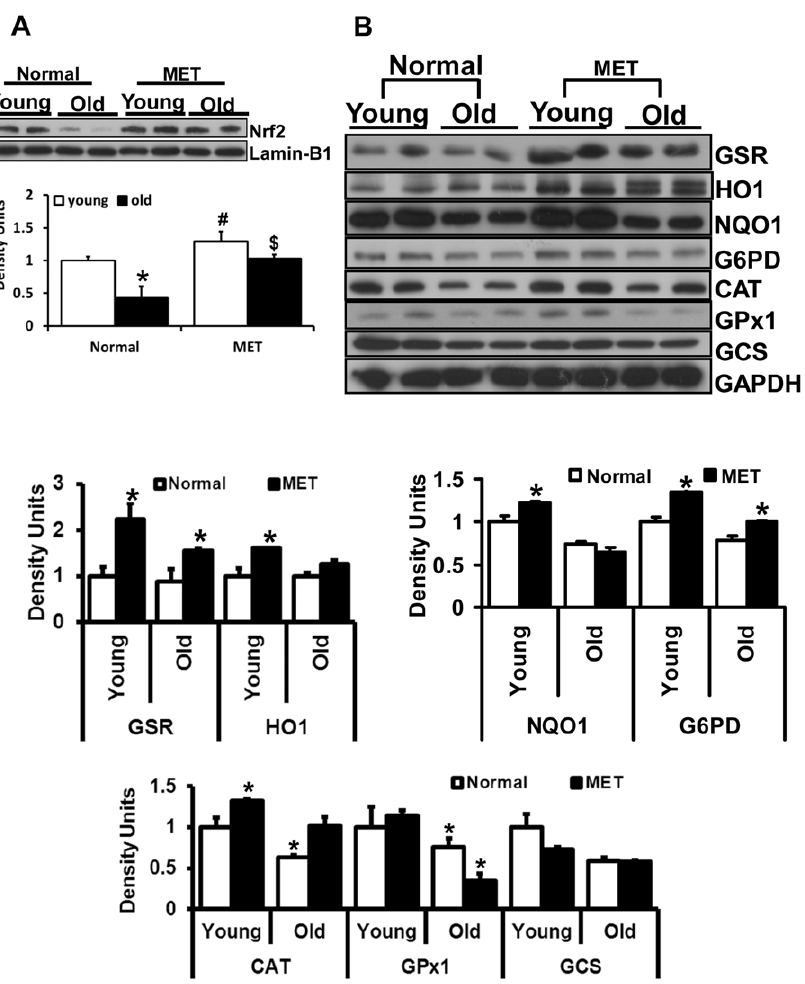
Figure 6. Effect of prolonged moderate exercise on Nrf2/ARE-Antioxidants in the aging heart. Representative immunoblots of cytosolic extracts from the hearts of young and old mice under basal conditions and following 6-weeks of moderate exercise training (MET). Protein blots were probed with respective antibodies as indicated. Individual lanes represent separate animals (n=4–6/group). A. Analysis of nuclear Nrf2 in young and old mice subjected to MET. In sedentary mice, Nrf2 protein levels were decreased significantly in old when compared to young (*p , 0.05). Following MET, nuclear Nrf2 levels were significantly increased in old mice to levels equivalent to those of young mice ( # , $ p , 0.05 in MET vs. respective basal). (B) Densitometry analysis of respective protein signals were performed using Image-J and expressed relative to mean values of the sedentary-young group. Under basal conditions, a significant decrease in the protein levels of GSR, G6PD, NQO1, catalase, GPX1 and GCS were observed in the heart tissues of old when compared to young mice. Following 6-weeks of moderate exercise, most of the antioxidants were significantly (*p , 0.05) upregulated or stabilized in the aging heart.